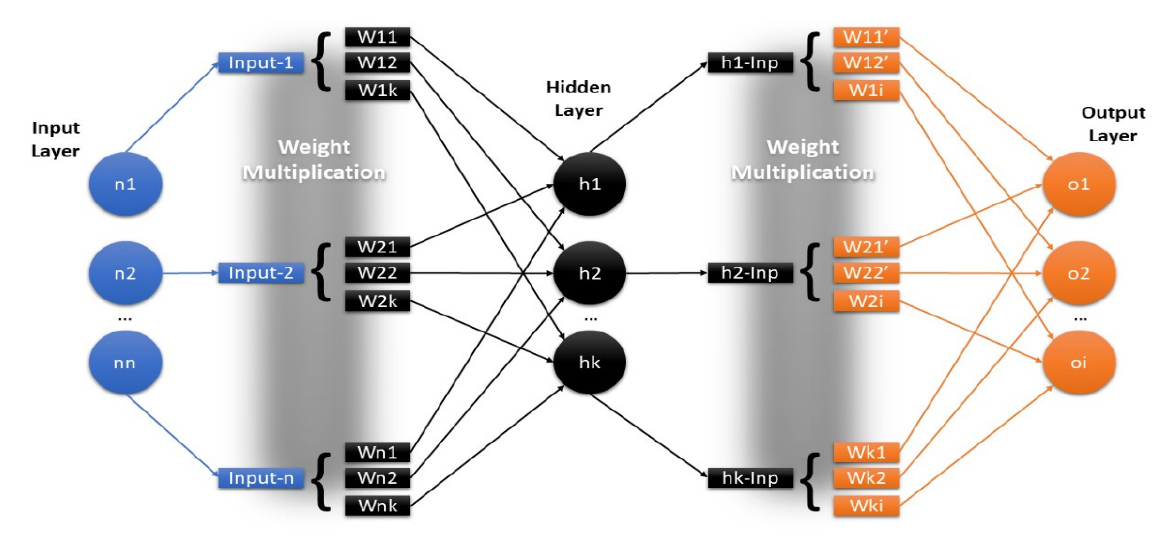
Figure 8. Multilayer perceptron (MLP) classifier structure.